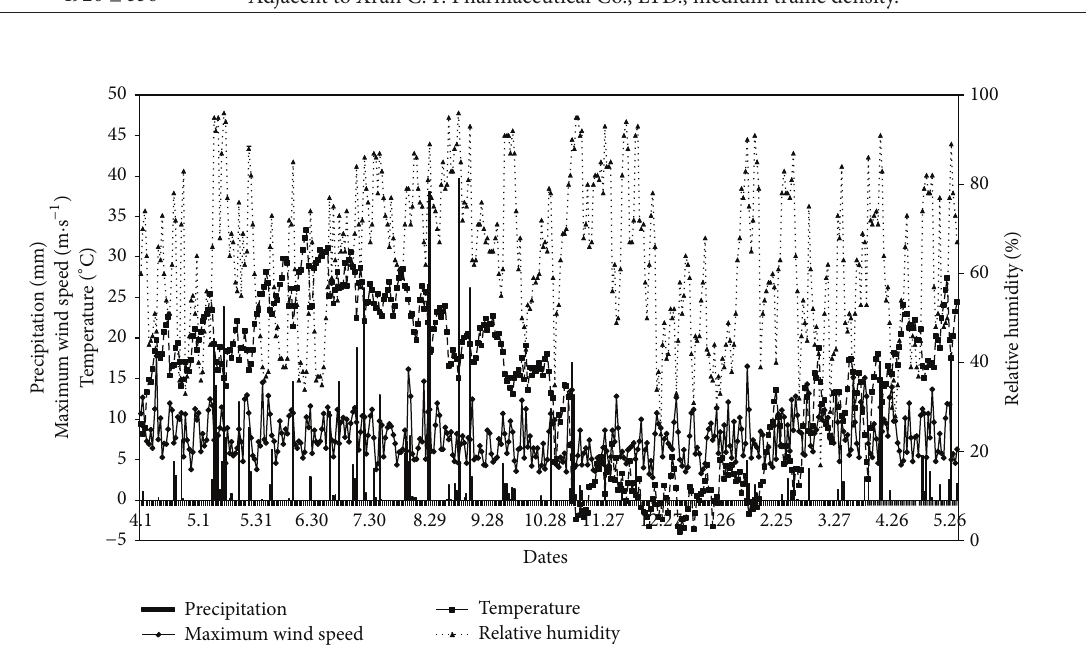
Figure 1: Diurnal variations of precipitation, maximum wind speed, and mean relative